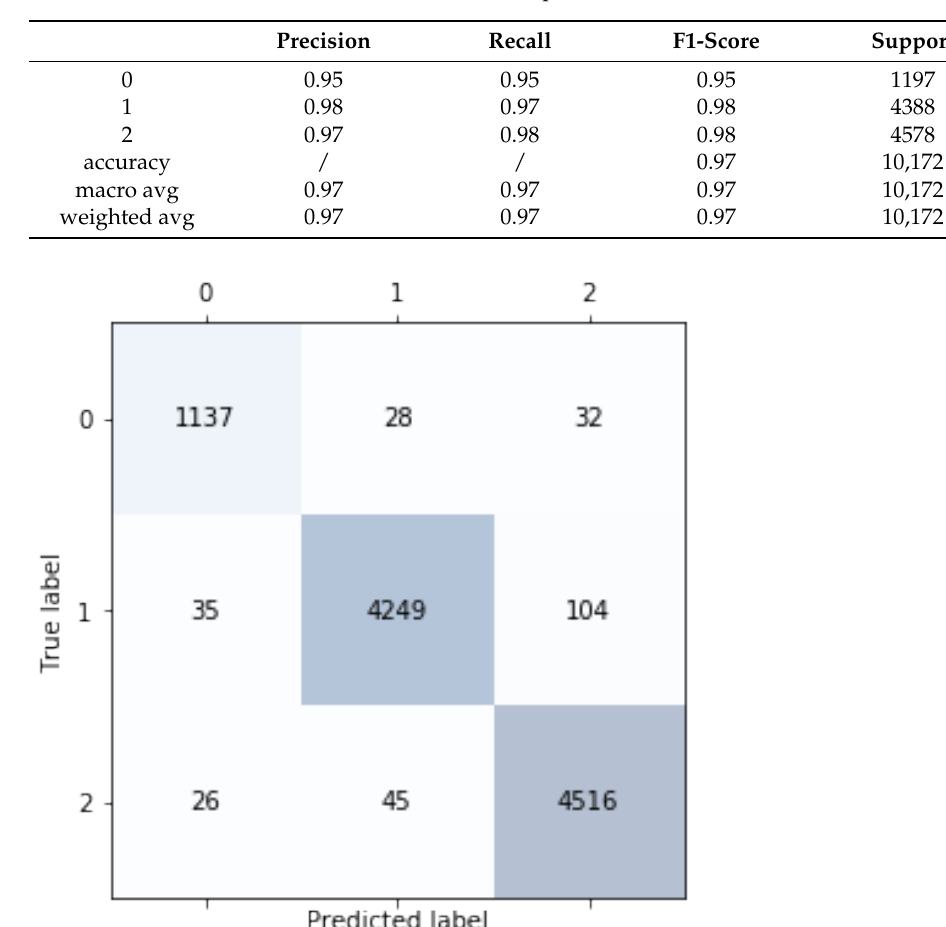
Figure 8. CNN-LSTM model training history for Bitcoin tweets. Table 6. CNN-LSTM Bitcoin tweets classification_report.